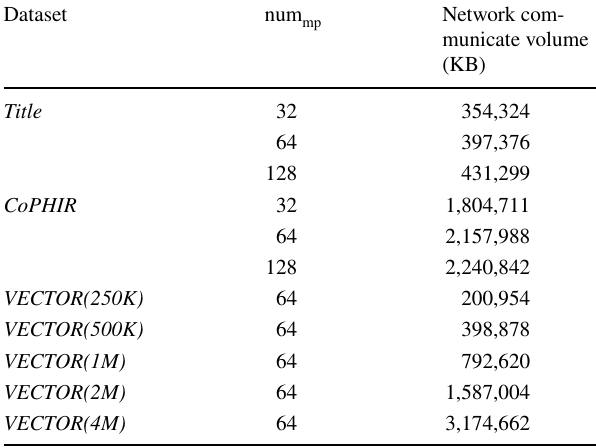
Table 4 Construction cost of AMDS